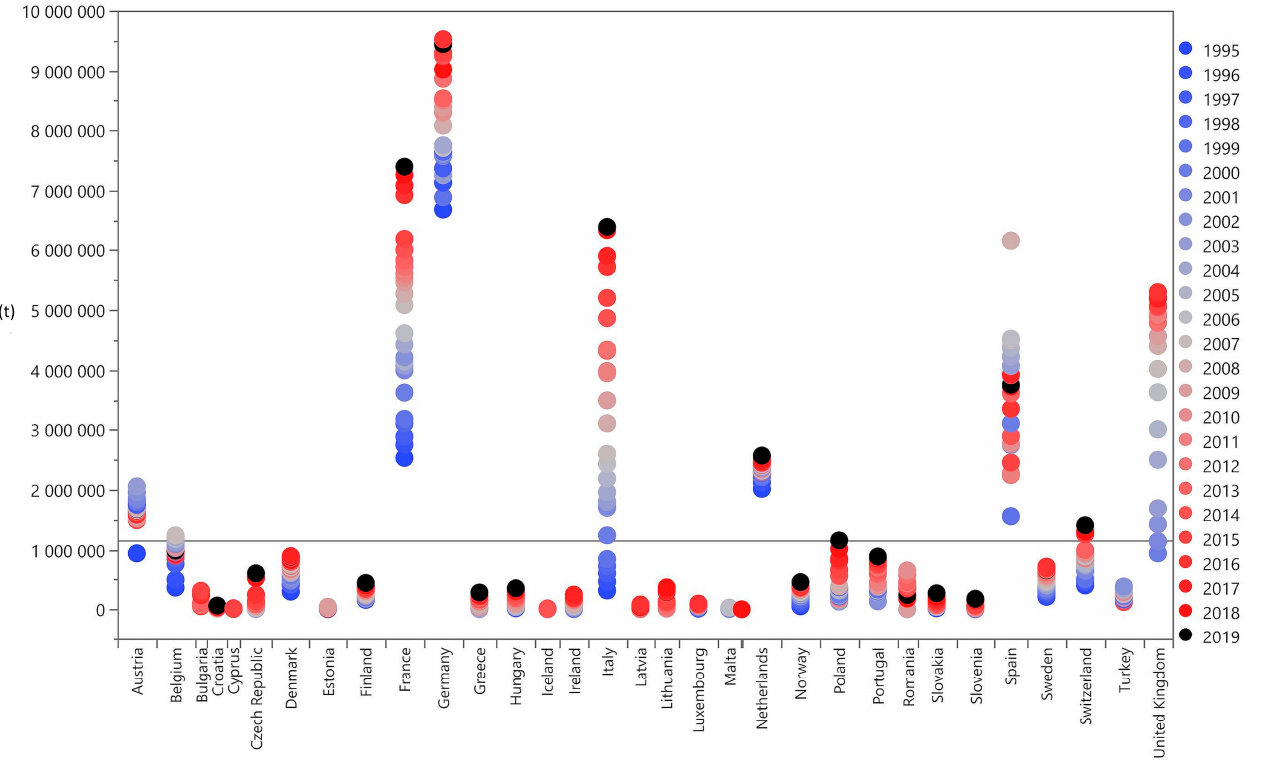
Figure 12. Energy recovery from municipal waste in the EU for the years 1995–2019. The results of this analysis are also influenced by the fact that energy recovery from municipal waste was not introduced and conducted in all EU countries at the same time.